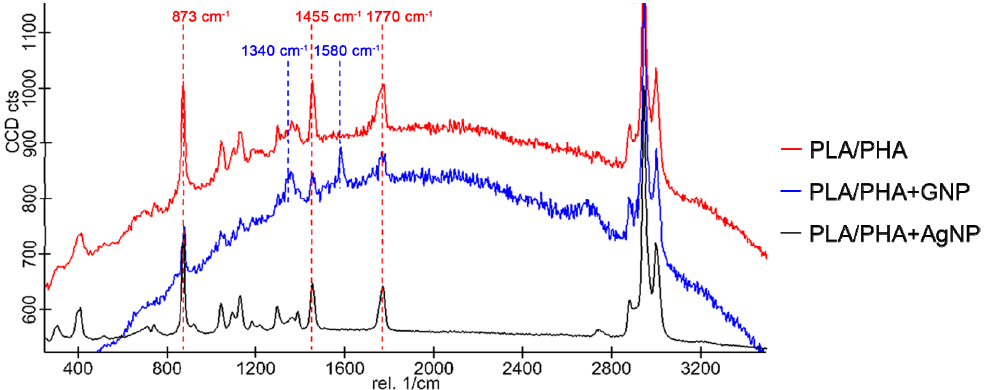
Figure 7. Raman spectra of PLA/PHA ( red ); PLA/PHA+GNP ( blue ); and PLA/PHA+AgNP ( black ). Characteristic peaks of PLA/PHA corresponding to ν C–OO and δ CH 3 asymmetric modes and C=O stretching at 873, 1455, and 1770 cm − 1 , respectively, are indicated in red. Characteristic D and G peaks of GNP at 1340 and 1580 cm − 1 , respectively, are indicated in blue. All spectra were taken with an integration time τ i = 2 s.